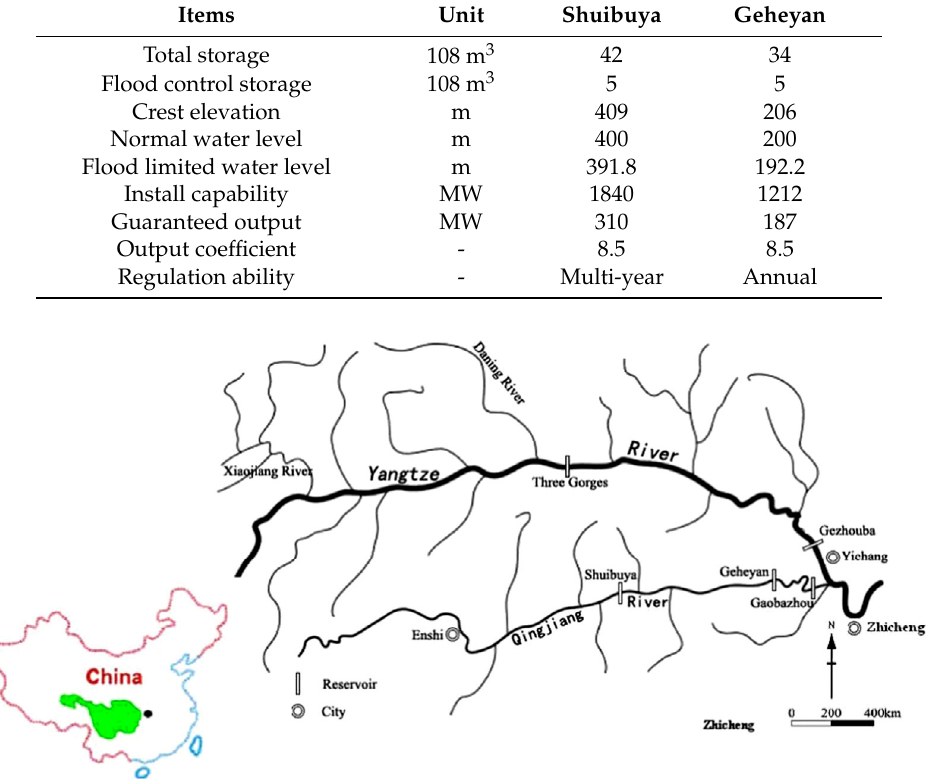
Figure 5. Plane sketch map of the Qingjiang cascade hydropower stations.